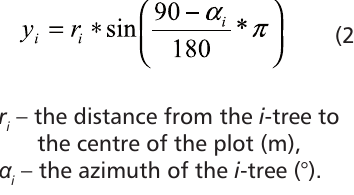
The position of the plots in the research area (the Repaš – Gabajeva Greda management